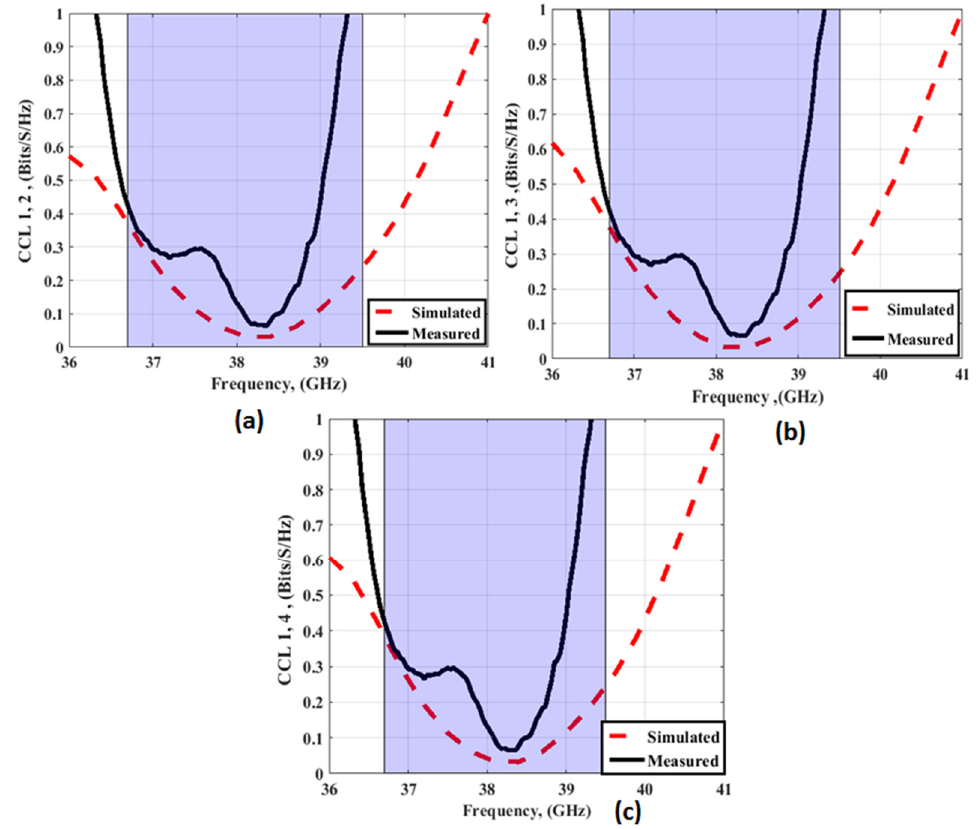
Figure 29. The CCL outcomes of the MIMO antenna with FSS at port 1 ( a ) CCL 1, 2 ( b ) CCL 1, 3 ( c ) CCL 1, 4. Table 1. The suggested antennas vs other